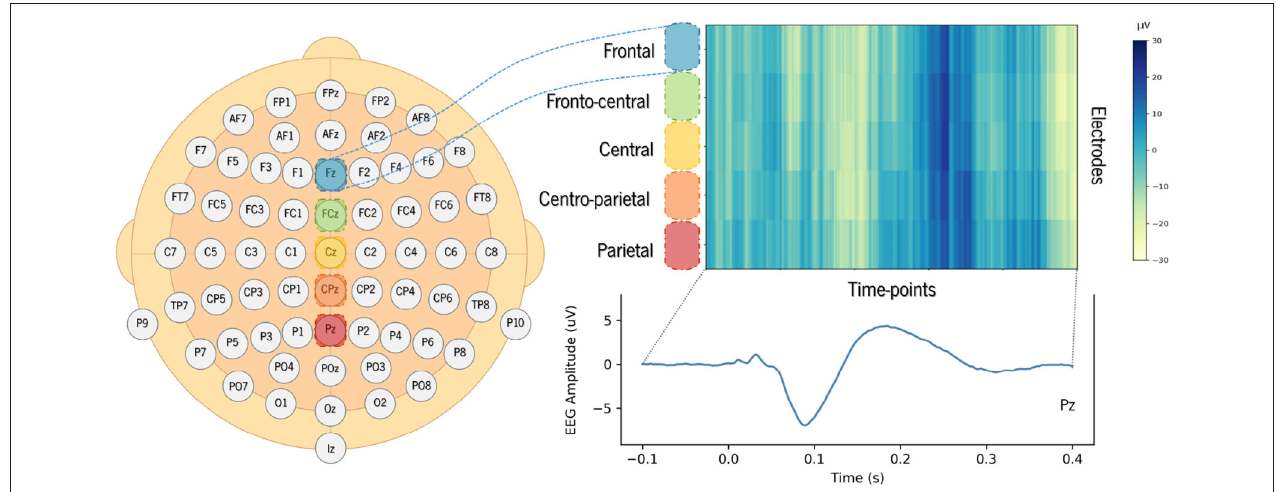
FIGURE 3 | Example of an EEG compounded 2D signal created from one single trial using a set of 5 electrodes. The color scale shows amplitude, in microvolts, over the time points recorded for each of the selected